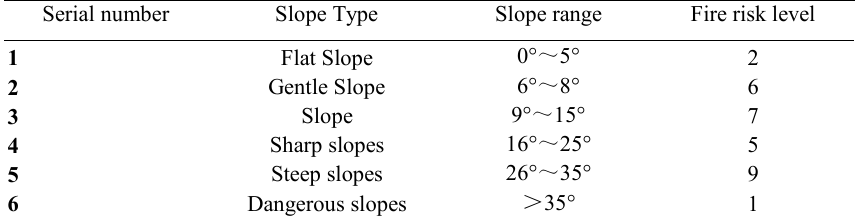
Table 1. Slope factor fire risk rating table.